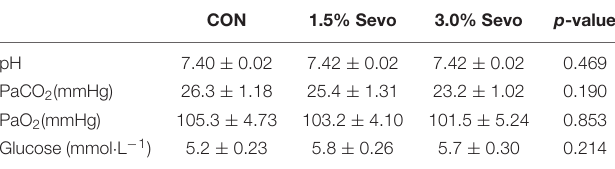
TABLE 1 | Arterial blood analysis of aged mice.